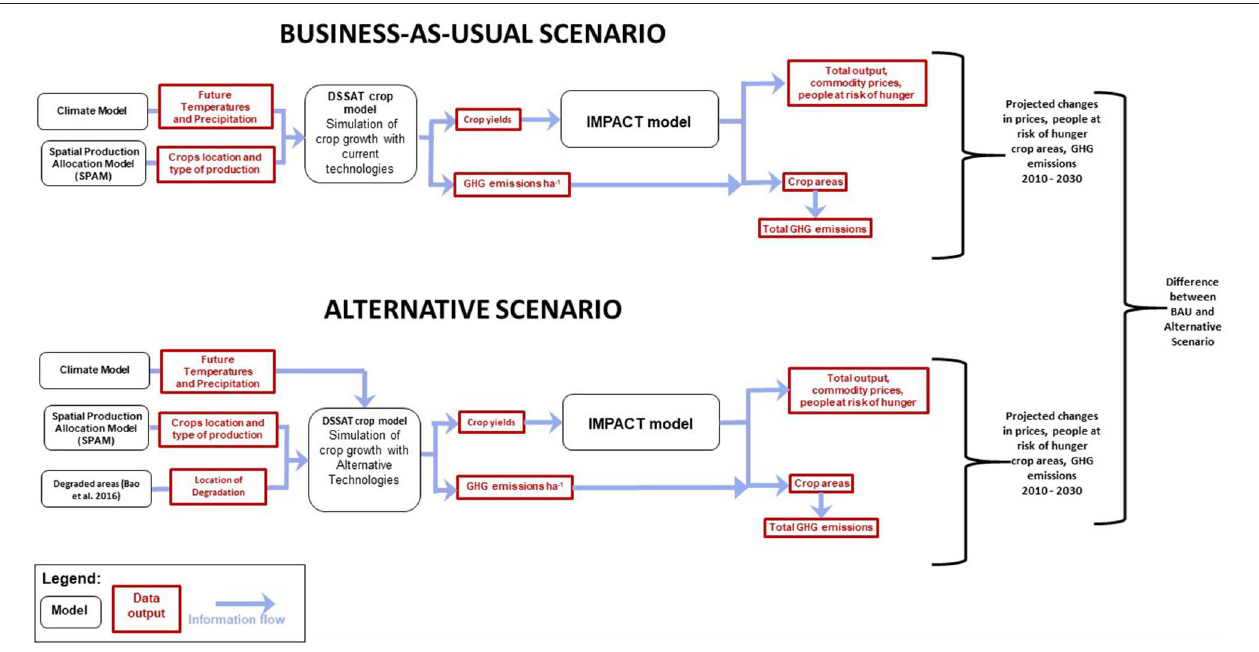
FIGURE 1 | Modeling steps and information flow.